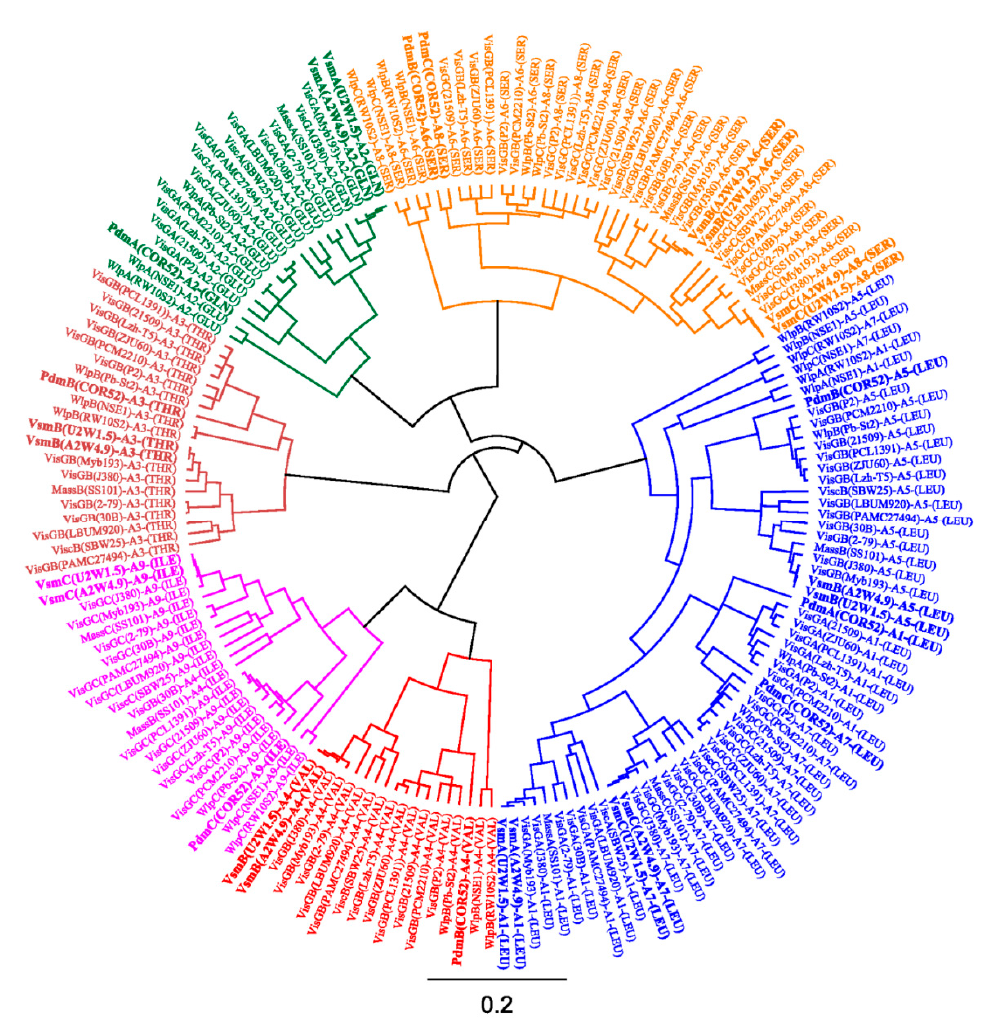
Figure 4. Phylogeny-based substrate prediction of pseudodesmin and viscosinamide synthetases. Cladogram of Maximum likelihood tree inferred from amino acid sequence alignment of adenylation (A) domains extracted from functionally characterized and select putative Pseudomonas NRPSs.